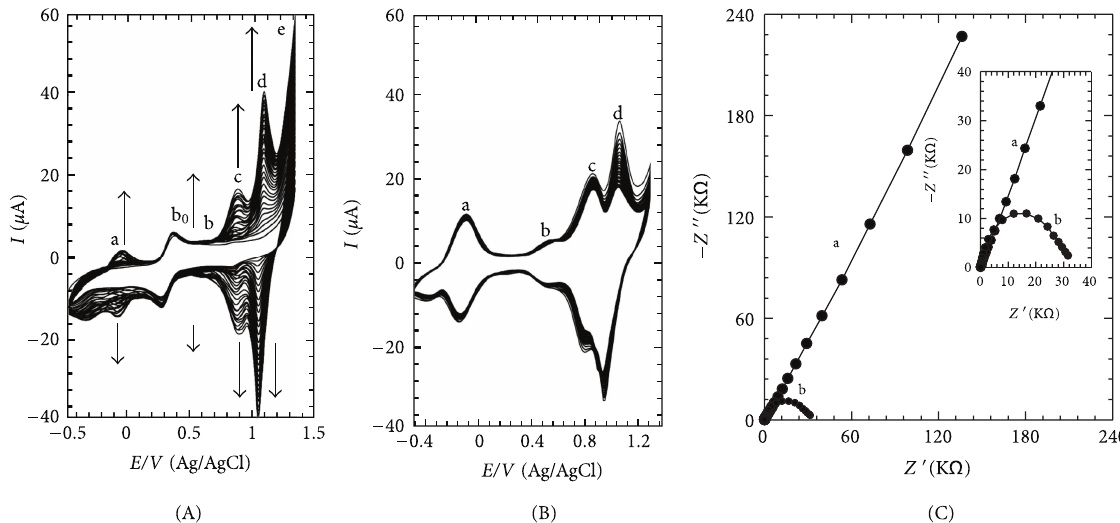
Figure 1: (A) Repeated cyclic voltammograms recorded on GCE in an aqueous solution containing 0.05 MHCl, 0.5MNaNO 3 , 1mMK 3 FeCN 6 , and 1mMRuCl 3 at pH 1.5 to obtain GC/RuOHCF/RuHCF modified electrode. (B) Consecutive cyclic voltammograms recorded on GC/RuOHCF/RuHCF modified electrode in a solution containing only 0.05 MHCl and 0.5 MNaNO 3 . Scan rate: 100 mV/s. (C) EIS complex plane plots obtained on (a) the bare GCE and (b) GC/RuOHCF/RuHCF modified electrode in a solution containing only 0.5MNaNO 3 at pH 1.5, E DC = +0.5 versus Ag/AgCl, E ac = 15mV, and frequency range: 10kHz to 10 mHz.